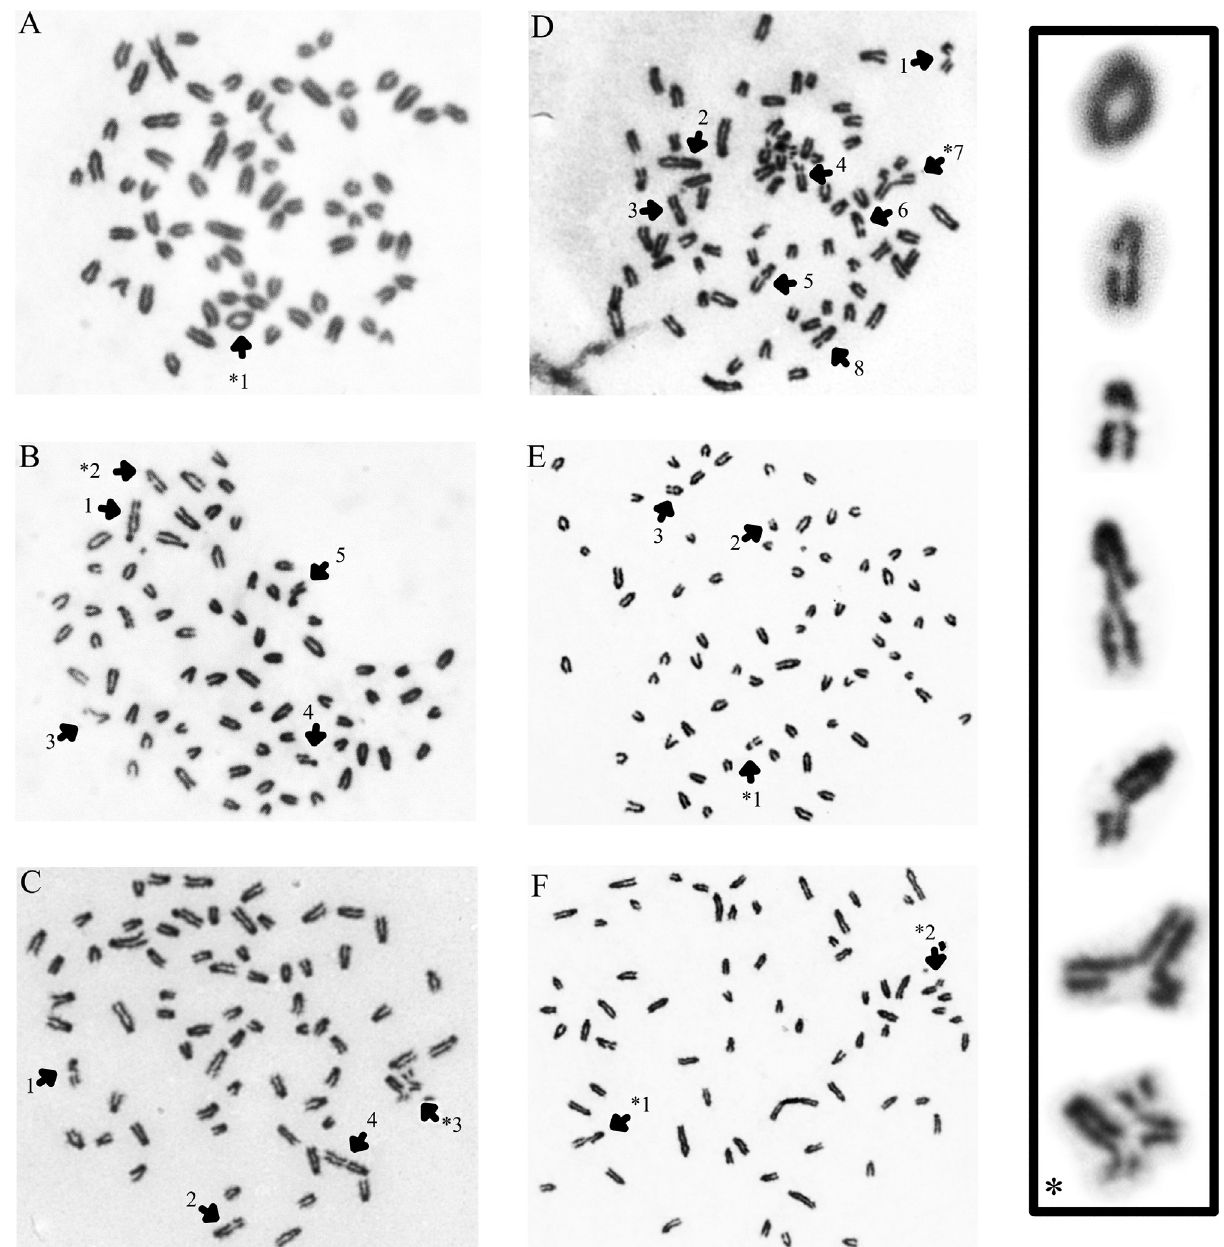
Figure2 -Differenttypesofchromosomalaberrationsobtainedindoxorubicin-treatedcellcultures.(A)1=ring;(B)1and2=chromatidgap,3,4and5= chromatid break; (C) 1 = chromatid break, 2 = chromatid gap, 3 = rearrangement and 4 = chromosome gap; (D) 1 = chromosome break, 2, 3, 5, 6 and 8 = chromatid gap, 4 = chromosome gap and 7 = triradial form; (E) 1, 2 and 3 = chromosome gap; (F) 1 = chromatid break and 2 = chromosome break. Chro- mosome preparations were stained with Giemsa and visualised at 1000x magnification. (*) Details of some chromosomal aberrations are shown at higher